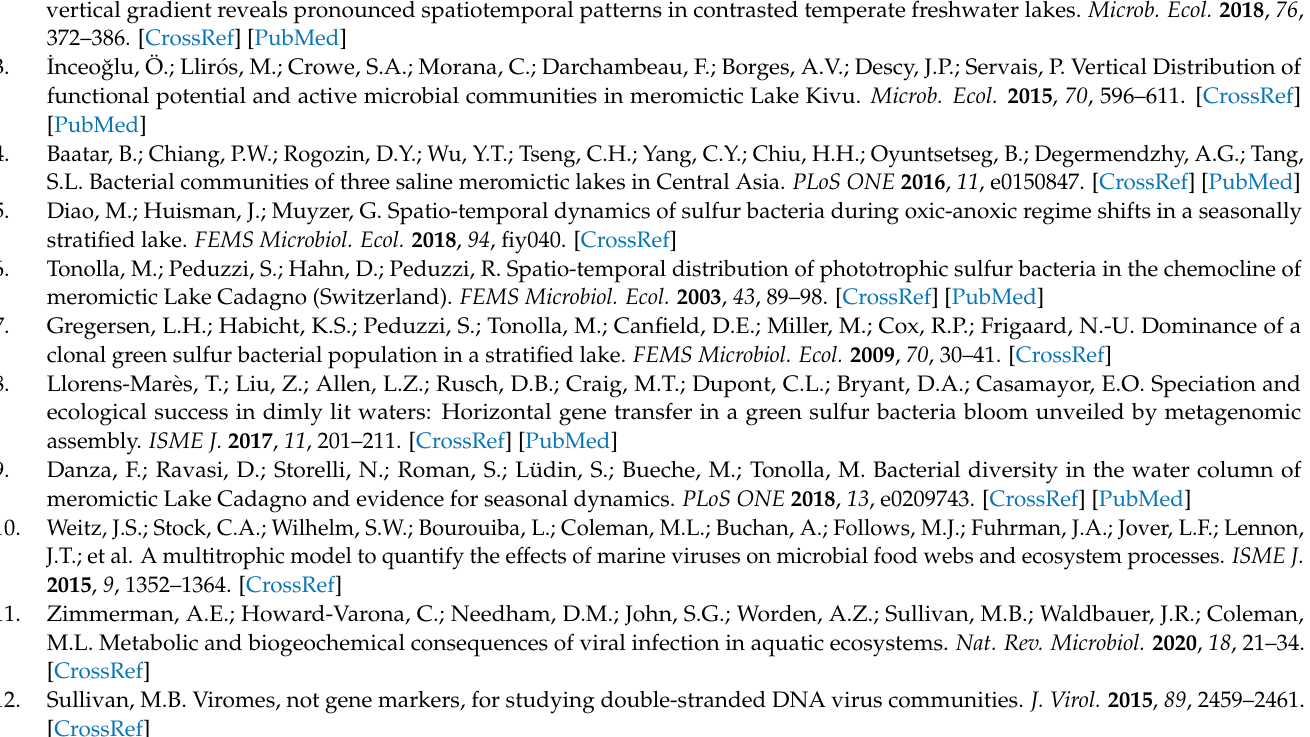
Table S6: Viral abundance estimates normalized as fragments per kilobase per mapped million reads (FPKM) for each individual C. clathratiforme SAG, Table S7: Genome annotations of C. clathratiforme SAGs-associated viral contigs, Table S8: Similarity matrix of Microviridae phage genomes (RefSeq DB; accessed March 2021) generated using VIRIDIC software, Table S9: Predicted protein coding genes in C. clathratiforme -associated phage sequences, Table S10: List of CRISPR spacer sequences and spacer sequence matches in C. clathratiforme SAGs-associated viral contigs and other known phages identified in the consensus C. clathratiforme genome. File S1. Genome annotation file